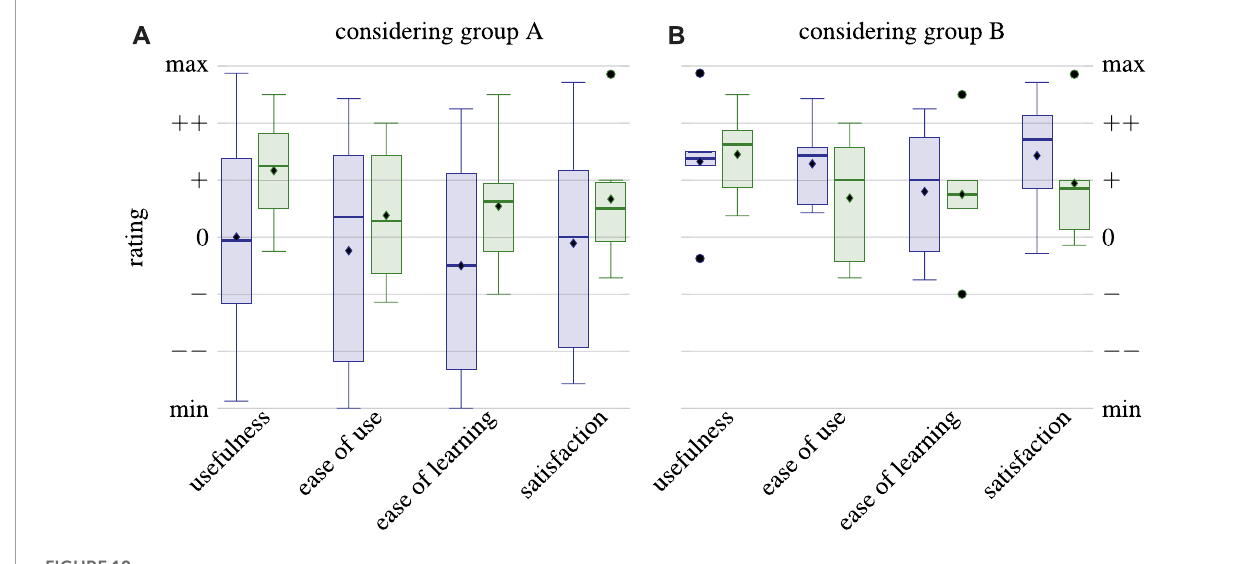
FIGURE 10 Statistical evaluation of the USE questionnaires. Each pair of box plots depicts results for ROS (left) and µRT (right), respectively. In the axis on the left-hand side (A) , all participants are considered, although only six participants filled in the questionnaire for µRT while 12 participants did so for ROS. On the right-hand side (B) , only five participants who filled in both questionnaires are considered.